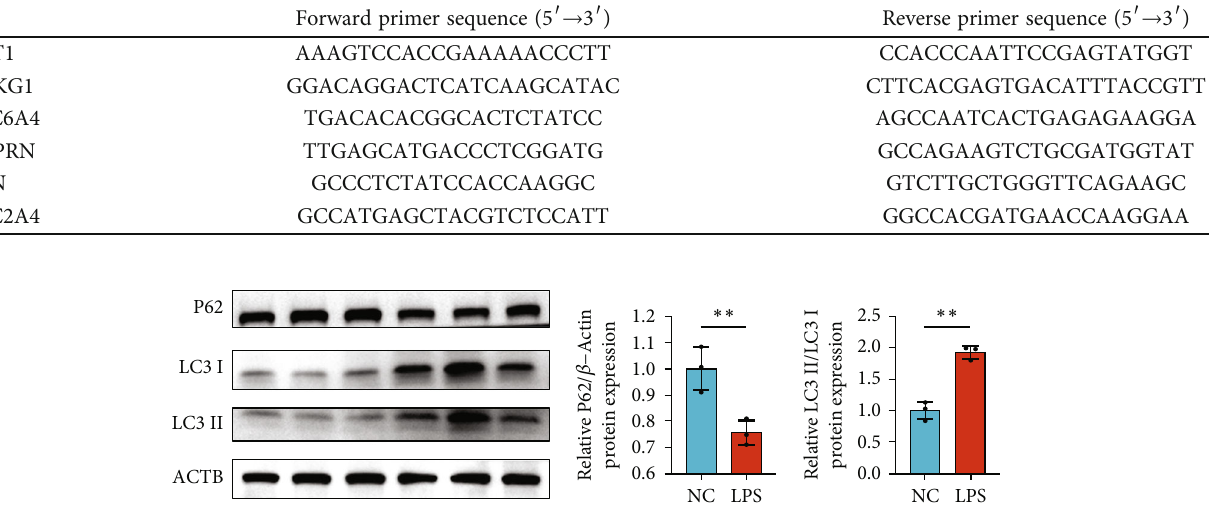
Figure 9: Autophagy promotion after LPS